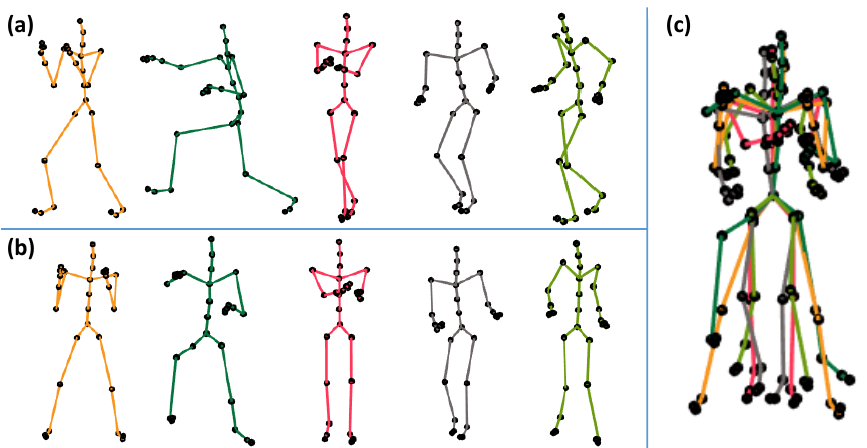
Figure 2. The process of normalization. ( a ) A representation of a few poses taken from different motion classes of the CMU-30 dataset. ( b ) The orientation information is removed from the poses. ( c ) The translational information is also removed to generate the final poses, which are ultimately normalized rotationally, as well as